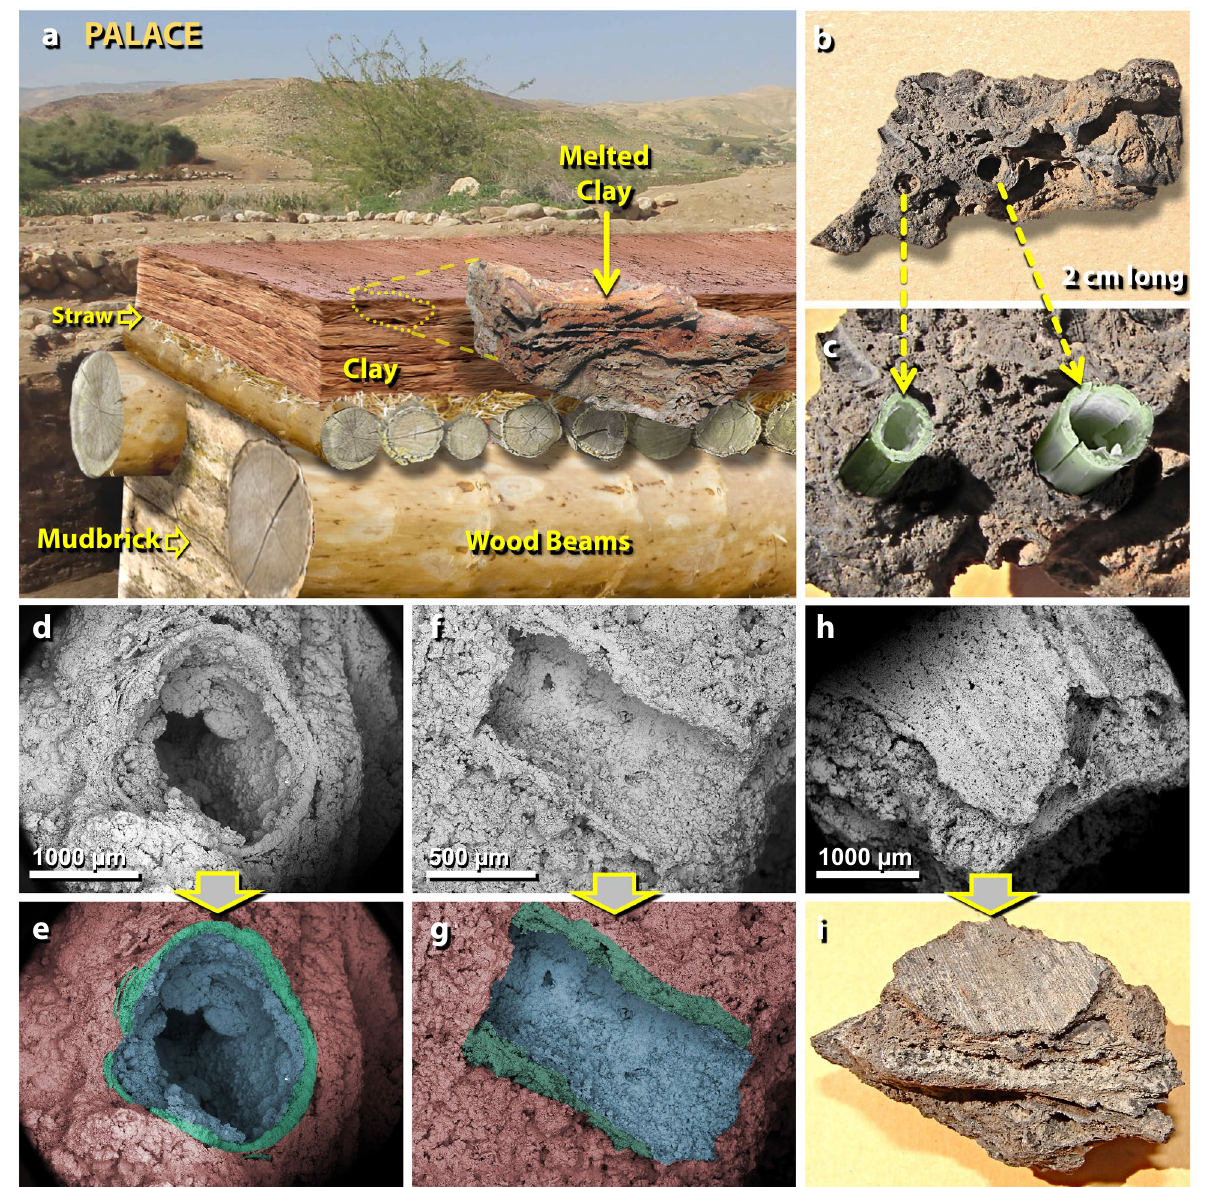
Figure 13. Melted palace roofing clay. ( a ) Artist’s cutaway depiction of typical roof construction at TeH. The construction involved sequentially plastering multiple layers of clay (~ 10 cm or more in total thickness) over a bed of leaves and straw placed over wood beams. “Melted clay” inset at middle right is a photo of melted roofing clay still displaying horizontal layers of clay plaster. ( b ) Fragment of melted roofing clay exhibiting ~ 2-mm-diameter tubular holes left after incineration of straw; ( c ) artist’s depiction, re-creating protruding straw before burning; ( d ) SEM image is the end-view of the hole left by burned straw embedded in roofing clay; ( e ) manually constructed EDS-based phase map of the same image, showing composition as determined by SEM–EDS; red represents melted clay matrix, green represents high-silica glass (60–90 wt.% SiO 2 ) formed from melted silicified straw, and blue represents the silica-rich interior of the hole. ( f ) SEM image is the side-view of the imprint left by burned straw; ( g ) manually constructed EDS-based phase map of the same image, color-coded as in the previous example. ( h ) SEM image of leaf imprint into the clay roofing material, showing the ribbed structure of a leaf; ( i ) photomicrograph of the same